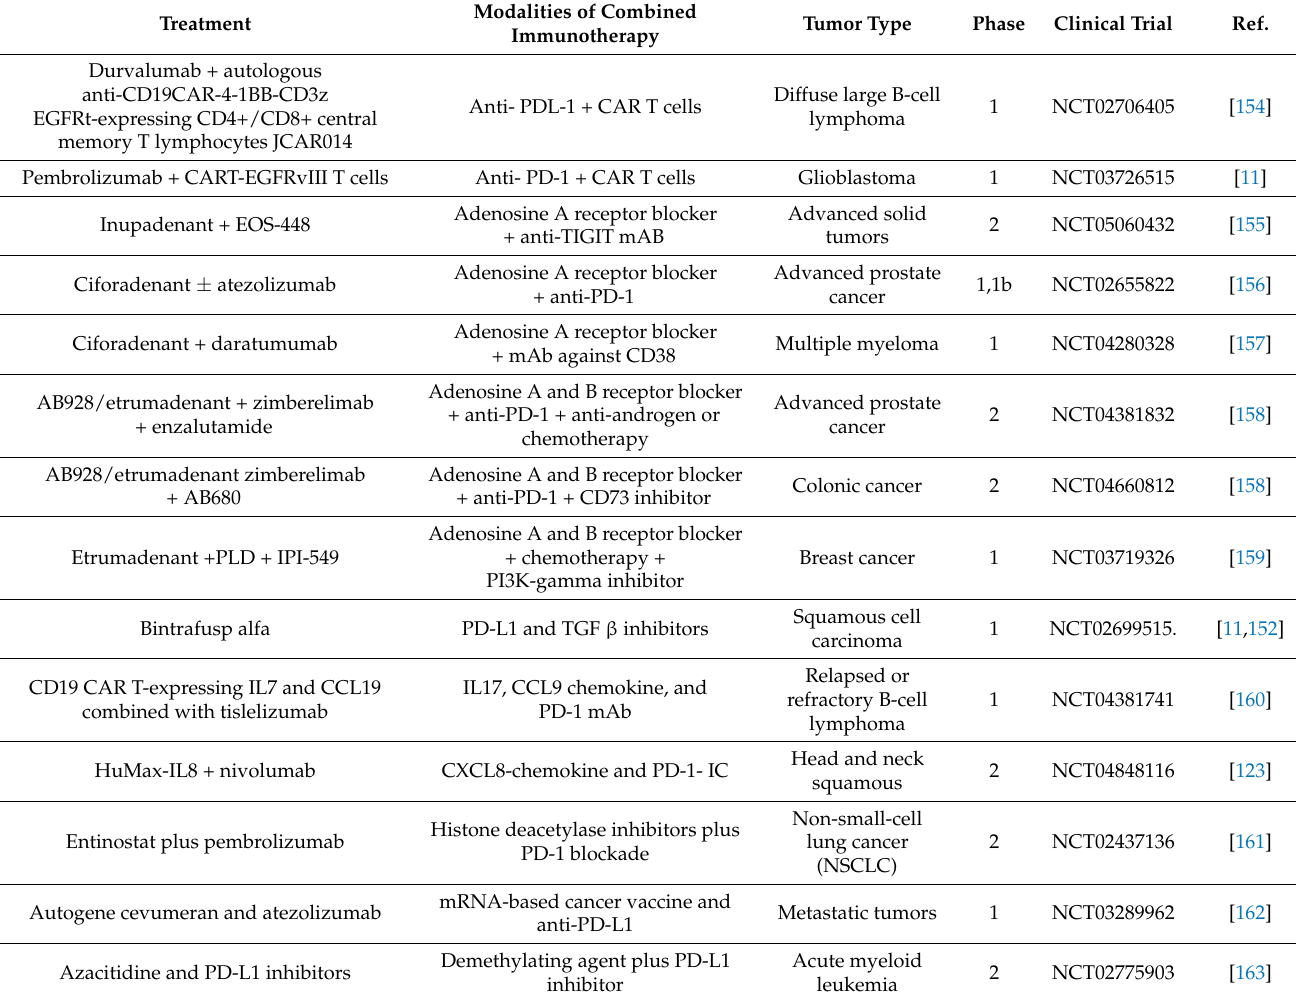
Table 1. Clinically approved combined immunotherapies in various cancers. Modalities of Combined Tumor Type Phase Clinical Trial Treatment Immunotherapy